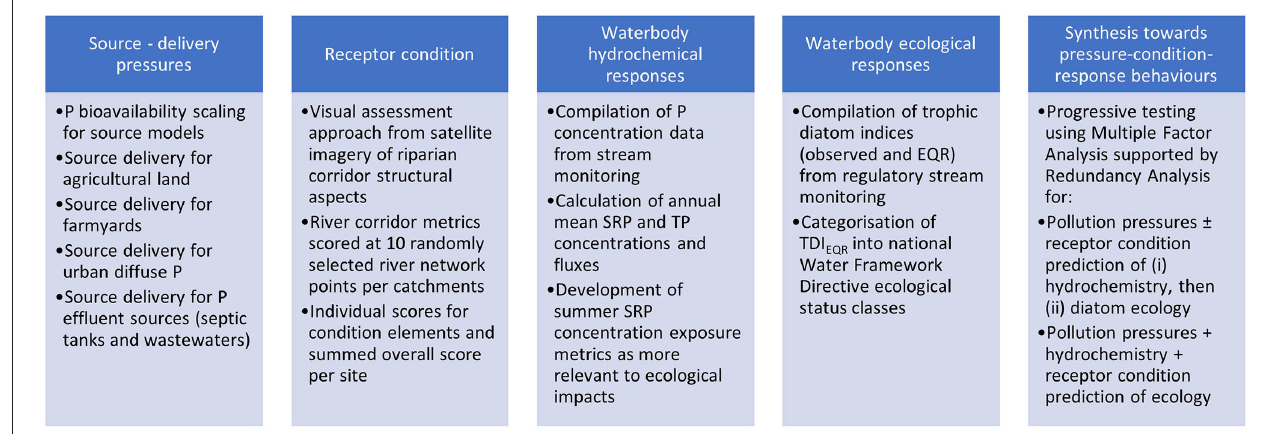
TABLE 1 | Selected properties of the 19 case study catchments. Catchment Lat, Long Abbrev- Allt a’Mharcaidh 57.123, −